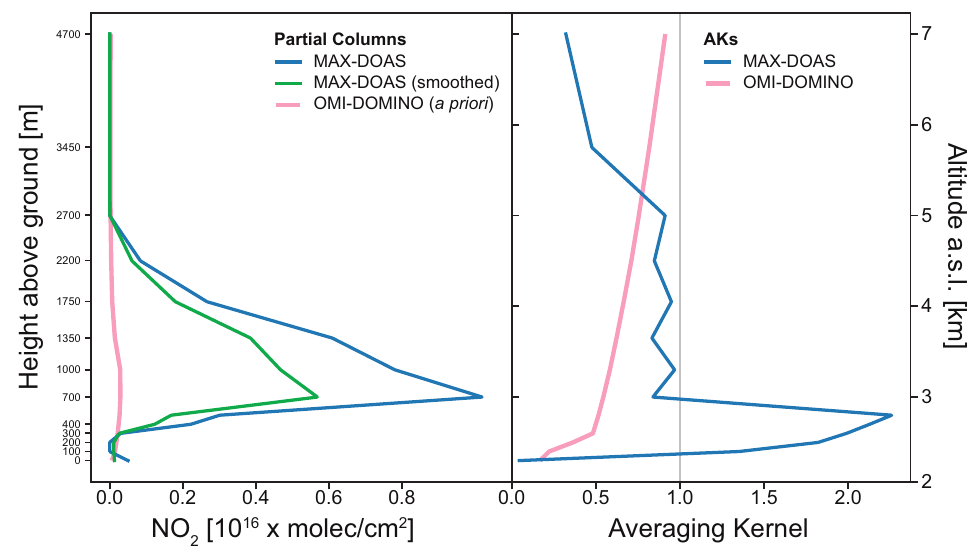
Figure 4. Left : Example of a MAX-DOAS NO 2 retrieved profile from 26 January 2013 (13:55 h LST) without (blue) and with smoothing with the AK from OMI (green). The OMI a priori profile is shown in pink. Right : Averaging Kernels from the OMI-DOMINO (pink) and MAX-DOAS (blue) products. The NO 2 Trop. VCD for this day in molec/cm 2 : MAX-DOAS 8.39 × 10 16 , MAX-DOAS smoothed 3.74 × 10 16 and DOMINO 3.55 × 10 16